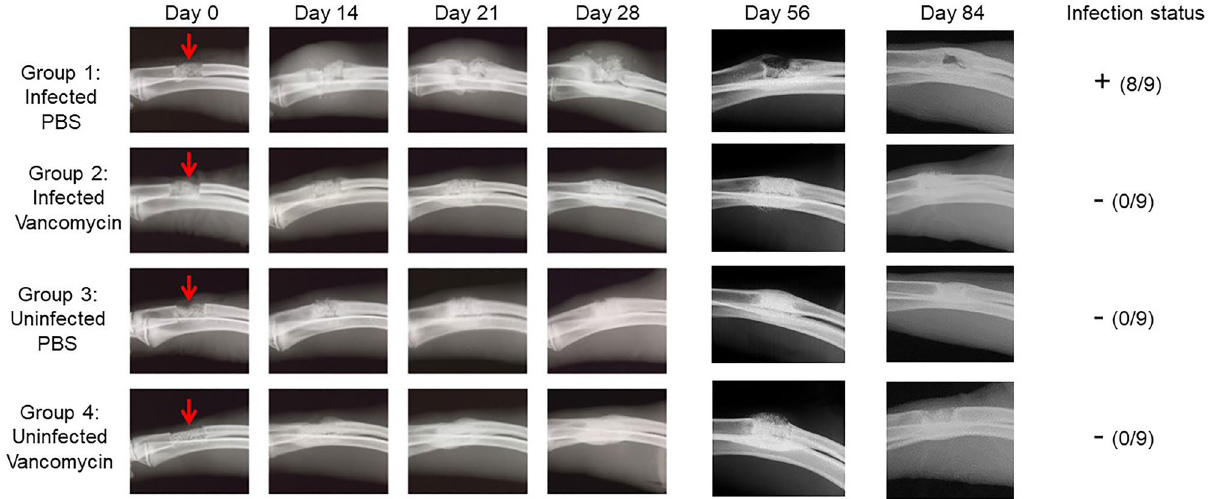
Figure 3. Bacteriological and radiographic evidence of osteomyelitis in experiments with the K20/100 scaffold formulation. A 1 cm defect (red arrow) was created in the right radius of rabbits as previously described 21 . The excised bone was discarded, and the distal and proximal ends of the remaining bone were either infected with S. aureus or inoculated with sterile PBS. The K20 formulation saturated with either PBS or vancomycin (100 mg/ mL) was then placed into the defect and the wound closed. Left: Radiographs from the indicated time points are grouped by infection status and whether the scaffold was loaded with PBS or vancomycin. Three independent experiments were performed with end points at 28, 56 or 84 days. At each end point, rabbits were humanely euthanized, the wound opened, and swabs taken for bacteriological analysis. Right: The collective results of the bacteriological analysis.